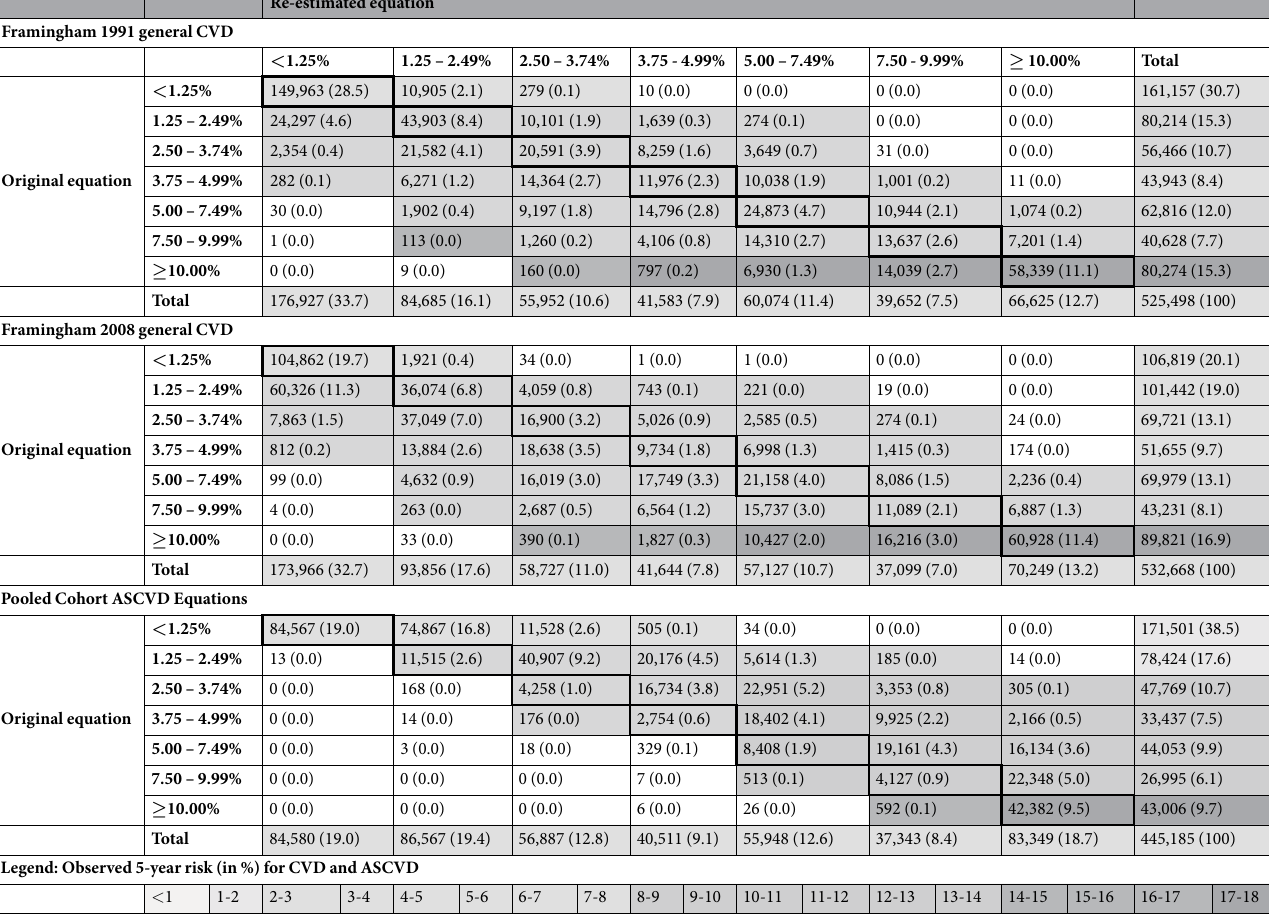
Table 3. Risk reclassification tables. Risk reclassification tables for the estimates 5-year risk (in %) for general cardiovascular disease (CVD) for the two Framingham equations and for atherosclerotic CVD (ASCVD) for the Pooled Cohort equations. Assuming constant hazard, approximately twice the estimated 5-year risk corresponds to the 10-year risk. For more details on the appropriateness of this assumption in this context and on the conversion, see Supplementary Figure 1. Individuals classified to cells in the diagonal (cells with a black frame) remain in the same risk category, irrespective if the original or the re-estimated equation is applied. All other individuals are re-classified to another risk category. Grey colors indicate the observed 5-year risk. The darker the grey color in a cell, the higher the observed 5-year risk of the individuals classified to this cell. (The observed 5-year risk was computed only for cells with at least 100 observations and at least one event.) If a re- estimated equation improves the discrimination of (AS-)CVD events, then separately for each row of Table 3, cells left of the diagonal should be colored in a lighter shade of grey compared to the cell in the diagonal, and cells right of the diagonal should be colored in a darker shade of grey compared to the cell in the diagonal. The observed 5-year risks and 95%-confidence intervals are reported in Supplementary Table 6. For a more precise view on the movement of participants between risk categories, we report reclassifications tables separate for women and men, individuals of different age groups, and for individuals with and without diabetes and hypertension in Supplementary Figure 3 and Table 7. Abbreviations: ASCVD, atherosclerotic cardiovascular disease; CVD, cardiovascular